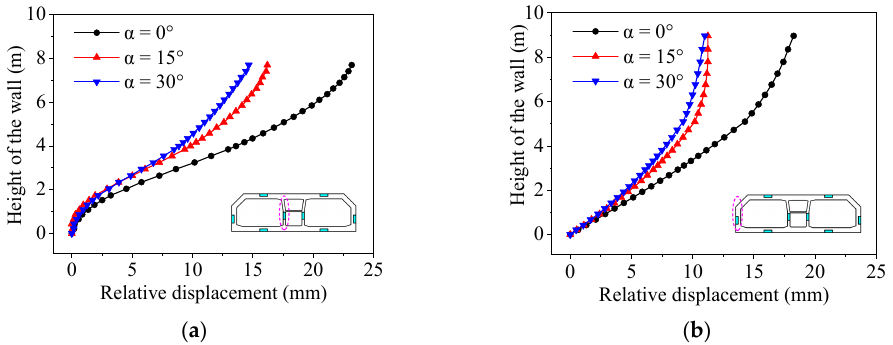
Figure 15. The maximum relative horizontal displacement of the wall: ( a ) the middle wall; ( b ) the side wall.